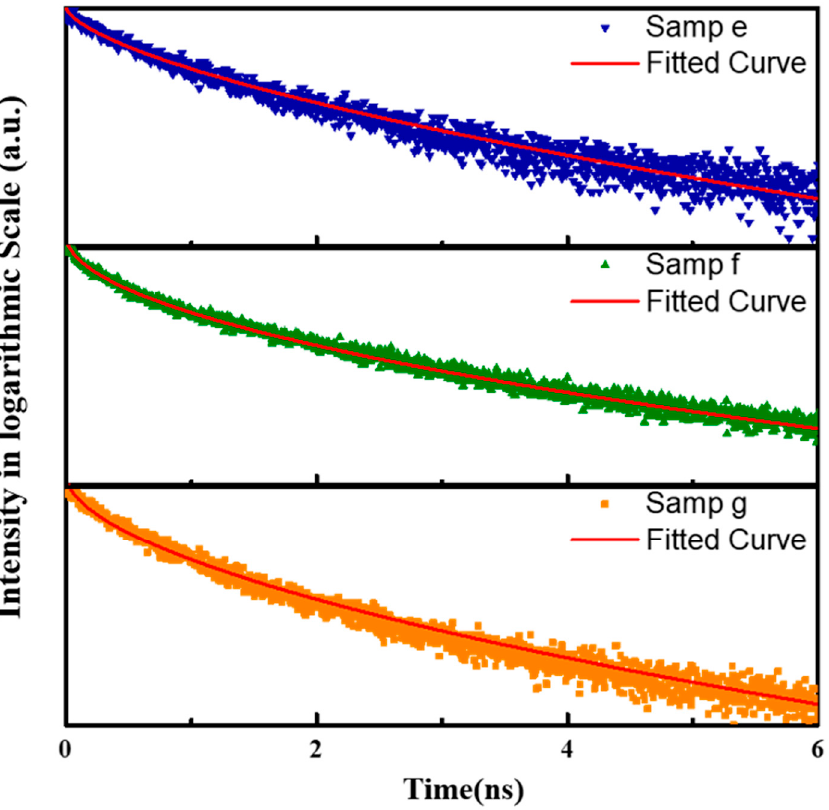
Figure 6. The radiative decay of samples e – g measured at 300 K with 266 nm of excitation. The red lines represent the fitted curve using a stretched exponential model. Table 2. Variation of radiative, nonradiative, and total carrier lifetime in samples e–g fitted by a stretched exponential model.